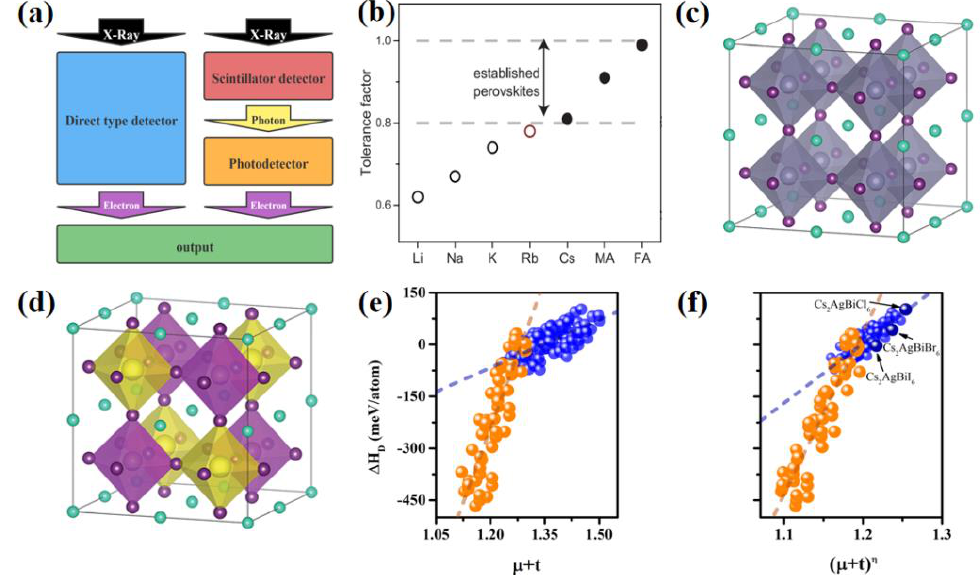
Figure 1. ( a ) Schematic diagram of direct and indirect X-ray testing. ( b ) The tolerance factor of component A element cations (Li + , Na + , K + , Ru + , MA + , FA + ) in APbI 3 . Theoretically, the element that can form a stable structure is a black solid circle, and Rb (red empty circle) is very close to 0.8 [28]. ( c ) Typical perovskite crystal structure diagram [30] and ( d ) double perovskite crystal structure diagram [30]. ∆ H D of 138 perovskite materials and ( e ) µ + t or ( f ) ( µ + t ) η . The criterion is linearly correlated. Blue and orange are halide and sulfide, respectively [29].